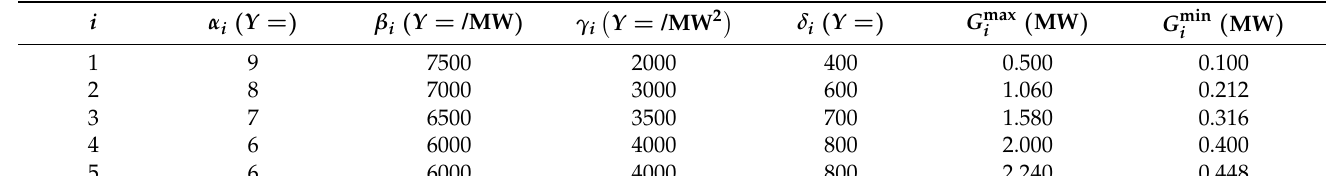
Table 1. Specifications of CGs. “¥” means “any currency unit is applicable”.